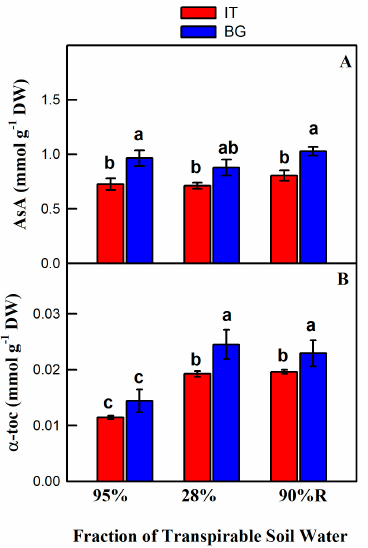
Figure 4. Antioxidant levels in Italian (IT, red bars) and Bulgarian (BG, blue bars) populations of P. orientalis plants under control (FTSW = 95%) and drought (FTSW = 28%) conditions and after re-watering (FTSW = 90%R). ( A ) Ascorbic acid; ( B ) α -tocopherol. Data are means ± SE of six independent samples. Statistically significant differences (Tukey’s test, p < 0.05) between the IT and BG populations are indicated by different letters.